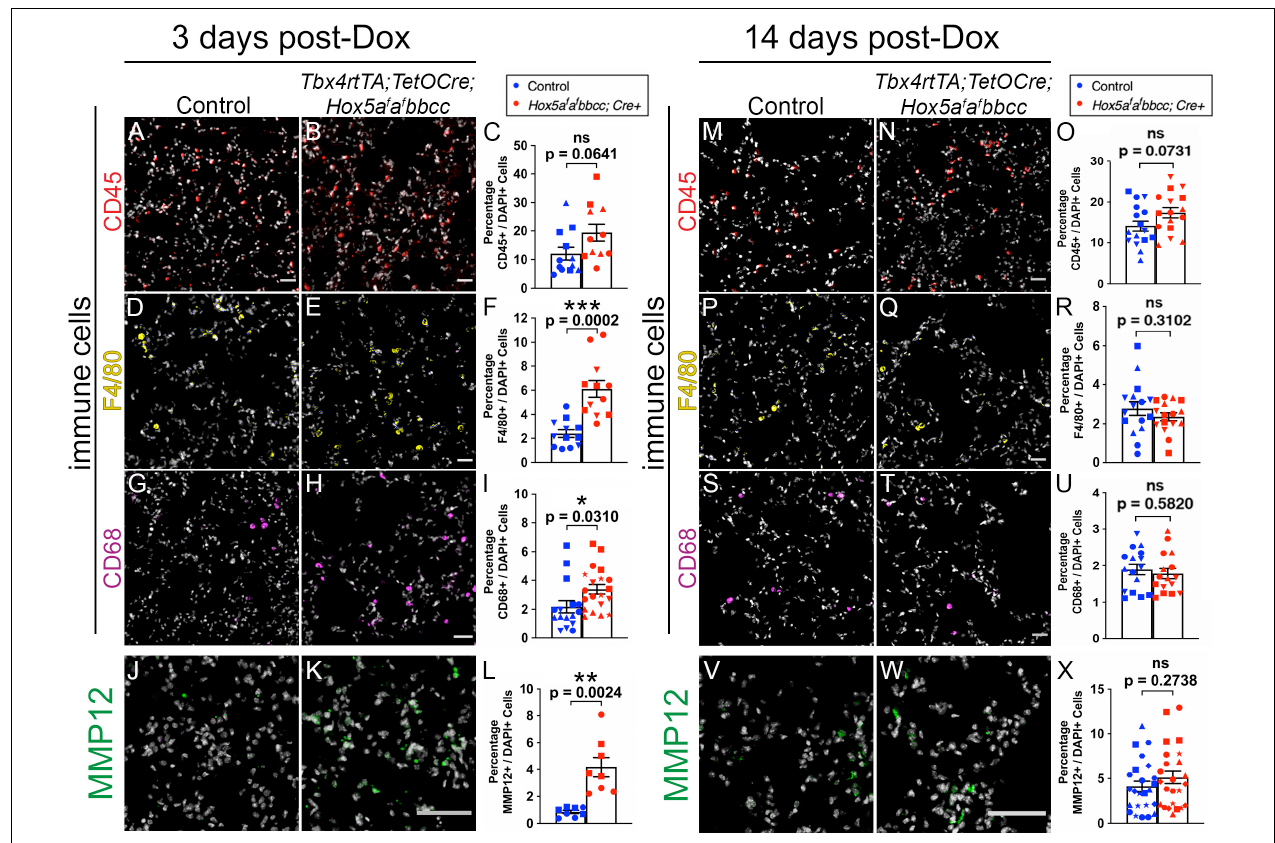
FIGURE 5 | Increased inflammatory response of macrophages and MMP12 expression levels 3 days after Hox5 deletion. Cryosections of control and mutant mice lungs (3 days post-Dox treatment initiated at 8 weeks of age) were stained with CD45 (red, A,B ), F4/80 (yellow, D,E ), CD68 (magenta, G,H ), and MMP12 (green, J,K ) with DAPI in gray. Quantifications of CD45- (C) , F4/80- (F), CD68- (I) , and MMP12- (L) positive cell numbers were normalized to DAPI-positive cell numbers and demonstrate significantly increased infiltration of macrophages and MMP12 staining levels in Hox5 mutant distal lungs. No increase of lung leukocyte, macrophage populations or MMP12 expression levels was observed 14 days post-Dox treatment (M–X) . Each shape represents an individual animal (ns, not significant). Scale bars: 50 µ m. P -values and statistical significance (*0.01 ≤ P < 0.05; **0.001 ≤ P < 0.01; ***0.0001 ≤ P < 0.001) were determined by an unpaired Student’s t